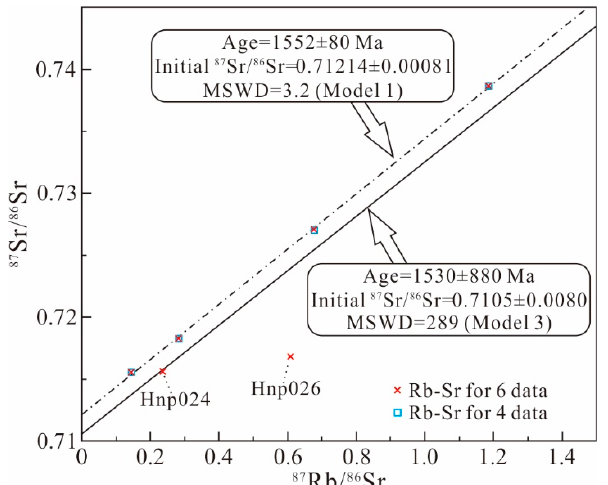
Figure6. 87 Rb / 86 Srvs. 87 Sr / 86 Figure 6. 87 Rb/ 86 Sr vs. 87 Sr/ 86 Sr isochron diagram of pyrite from laminated ores in the Hongnipo deposit.